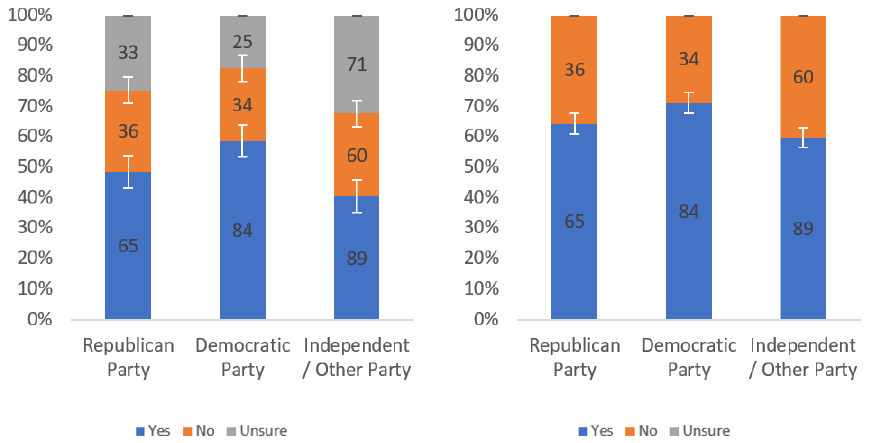
Figure A41. Responses regarding others’ willingness to review by political affiliation including ( left ) and excluding ( right ) unsure responses.